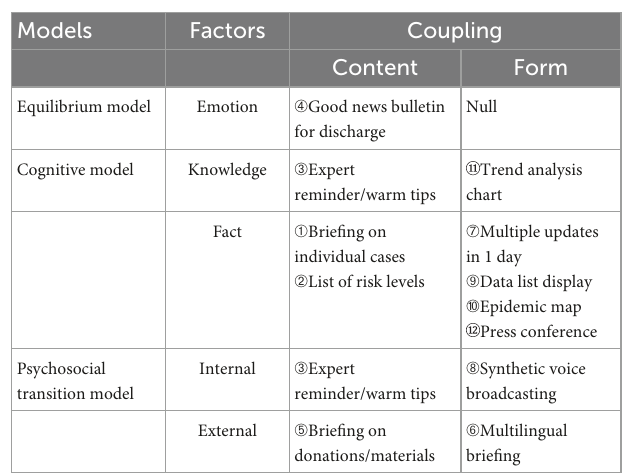
TABLE 4 Categories of innovative ways of